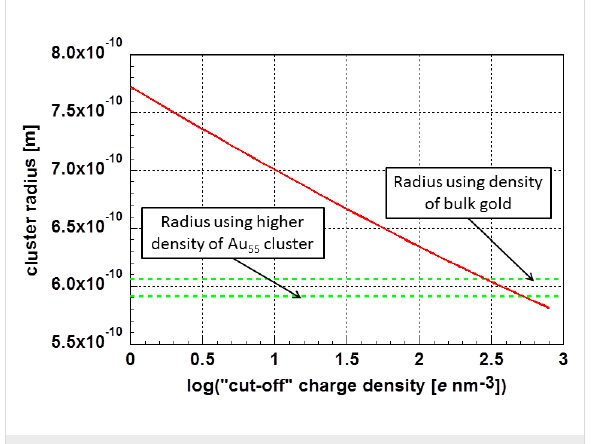
Figure 8: Dependency of the radius of the glassy Au 55 cluster on the “cut-off” charge density. The calculated radii of the Au 55 cluster assuming the mass density of bulk gold, as well as the calculated cluster radii considering the reduced atomic spacing (higher mass den- sity) in the Au 55 cluster, are marked.